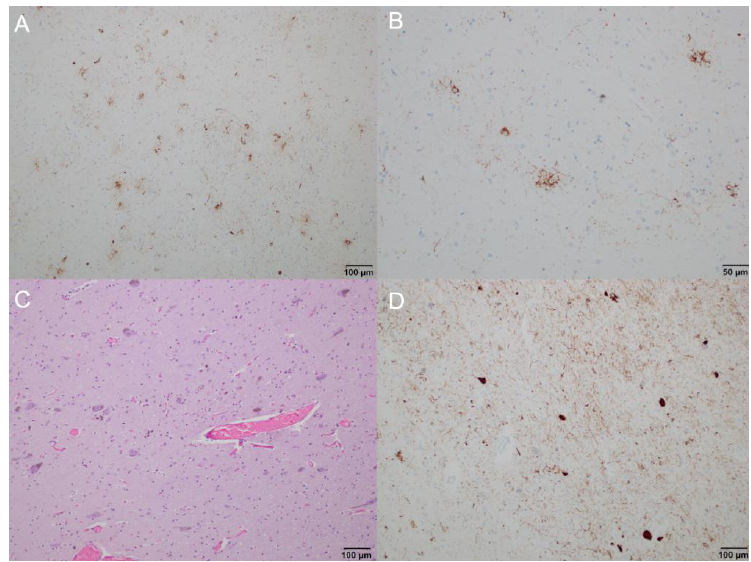
Figure 2. Brain neuropathology, microscopic anatomy: ( A ) immunohistochemistry staining showing tau accumulation in the putamen, predominantly in the form of tufted astrocytes and tau-positive neurons (100× magnification); ( B ) immunohistochemistry staining showing tufted astrocytes in the caudate nucleus (200× magnification); ( C , D ) substantia nigra showing neuronal cell loss, tau-positive neurons, and numerous neuropil threads (( C ) hematoxylin and eosin staining; ( D ) immunohistochemistry staining; 100× magnification).